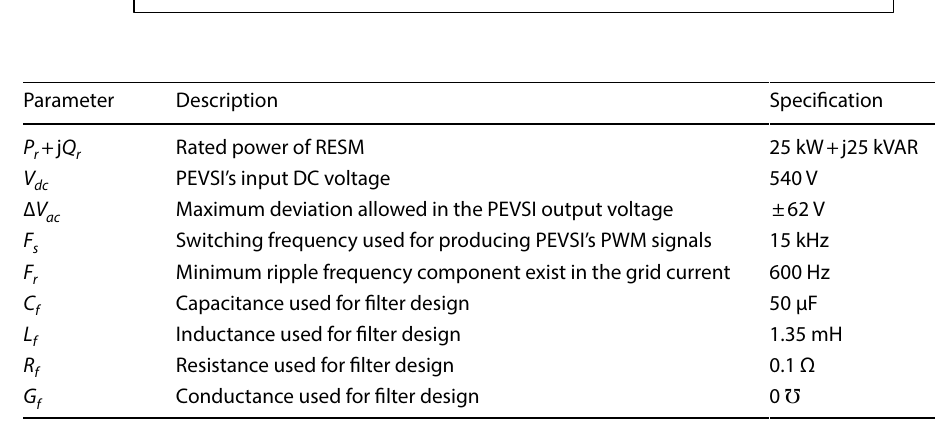
Disturbances (Load variations, Faults, etc.) 2 )( +++ KKsKKKKsKK ++ IAIVPAIVIAPVPAPV 234 )()( +++++++ sKGsKCRGKGsRCKCLGsLC IAfIAfffPAfffPAfffff Microgrid Plant Model